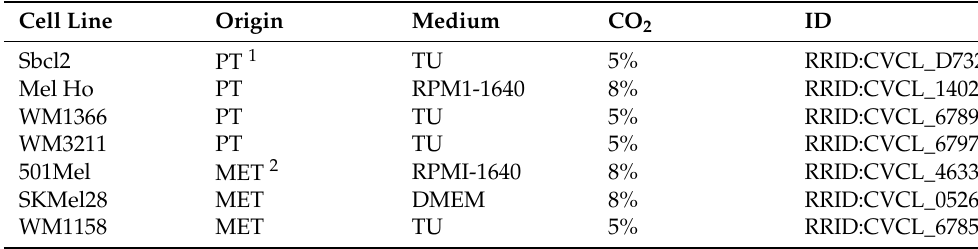
Table 1. Human cutaneous melanoma cell lines.